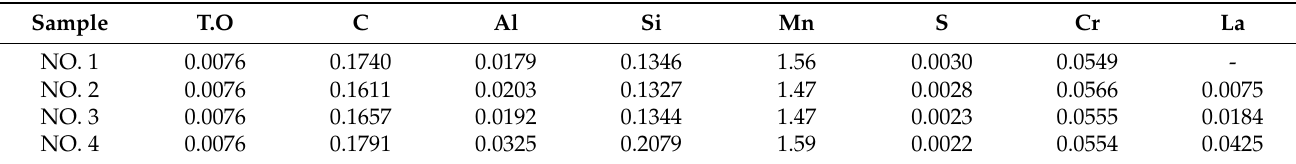
Table 1. Chemical composition of Q355B weathering steels with different lanthanum contents (wt.%).